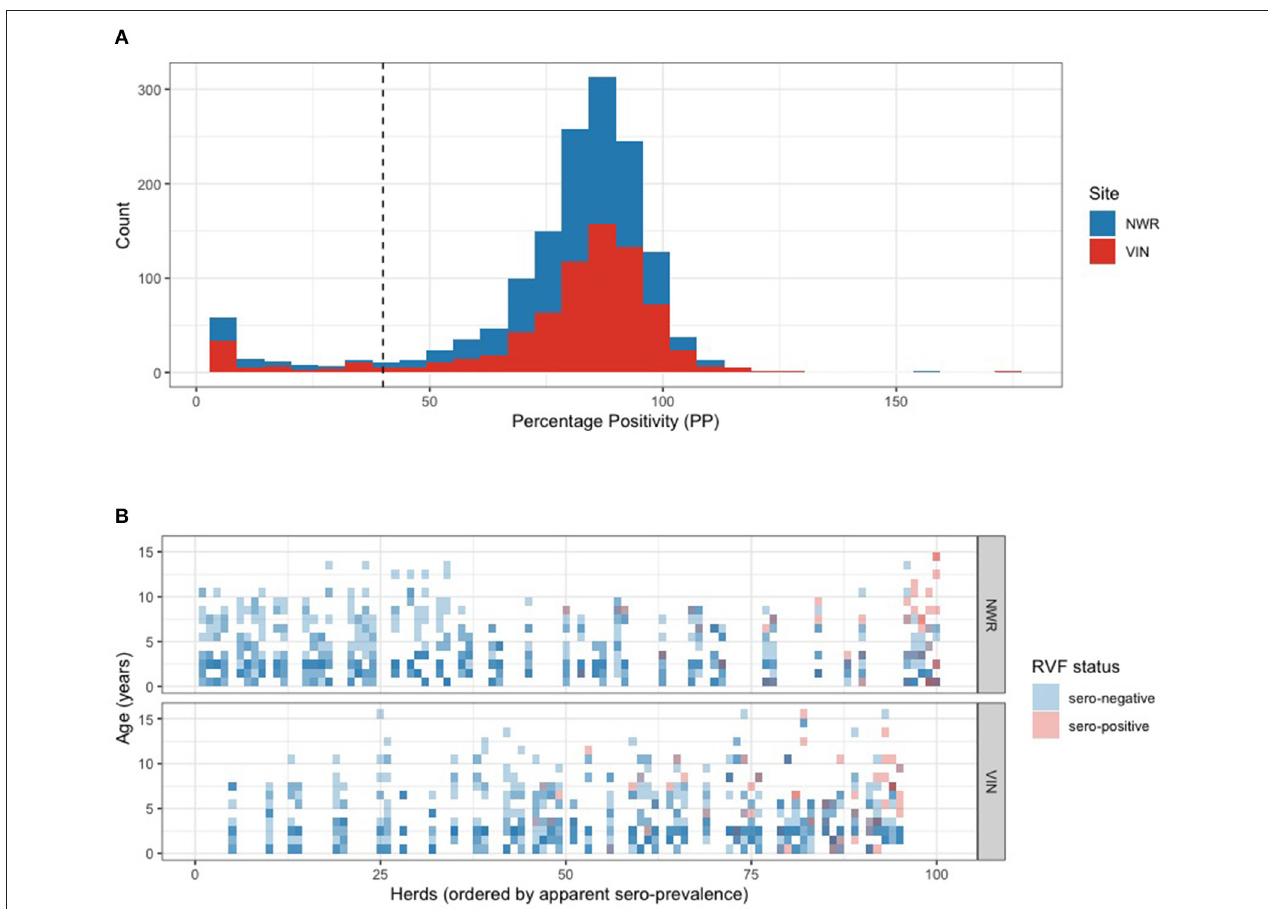
FIGURE 2 | (A) Histogram of the percentage positivity results for individual cattle in Cameroon in 2012 for antibodies to RVFV using the ID.vet commercial multispecies ELISA. Cattle were considered seropositive if the percentage positivity (PP) value was ≤ 40. (B) Tile plot of individual animal seropositivity status, where seronegative animals are a blue tile and seropositive animals are a red tile (binary), by age in years (y-axis), grouped by herd (i.e., all the 15 animals from a herd are in the same vertical column), ordered by herd prevalence with lowest on the left to highest on the right (x-axis), and stratified by study site (Color opacity variation arises where tiles of more than one animal are